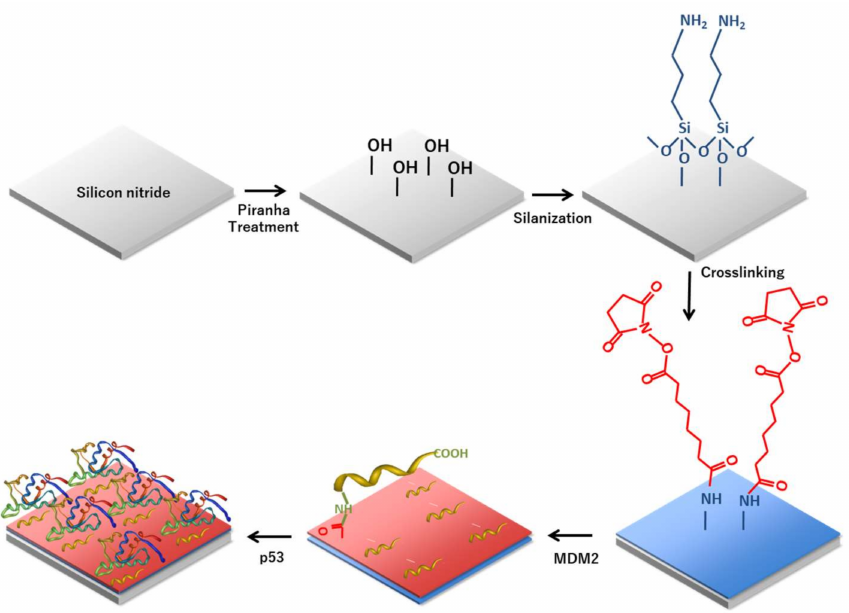
Figure 4. Functionalization approach utilized on silicon nitride surface to conjugate murine double minute 2 (MDM2) recombinant protein able to detect